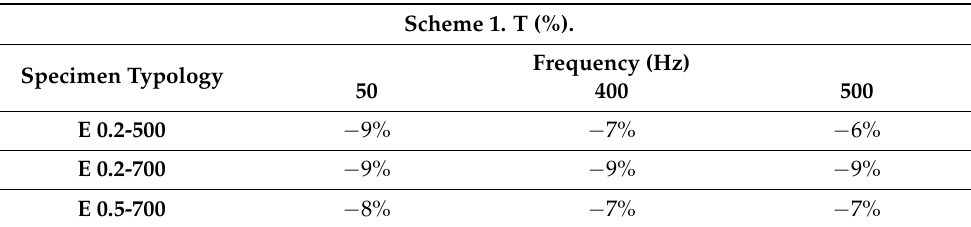
Table 3. Effect of the operating temperature condition on specific iron losses % reduction (comparison between 20 ◦ C and 125 ◦